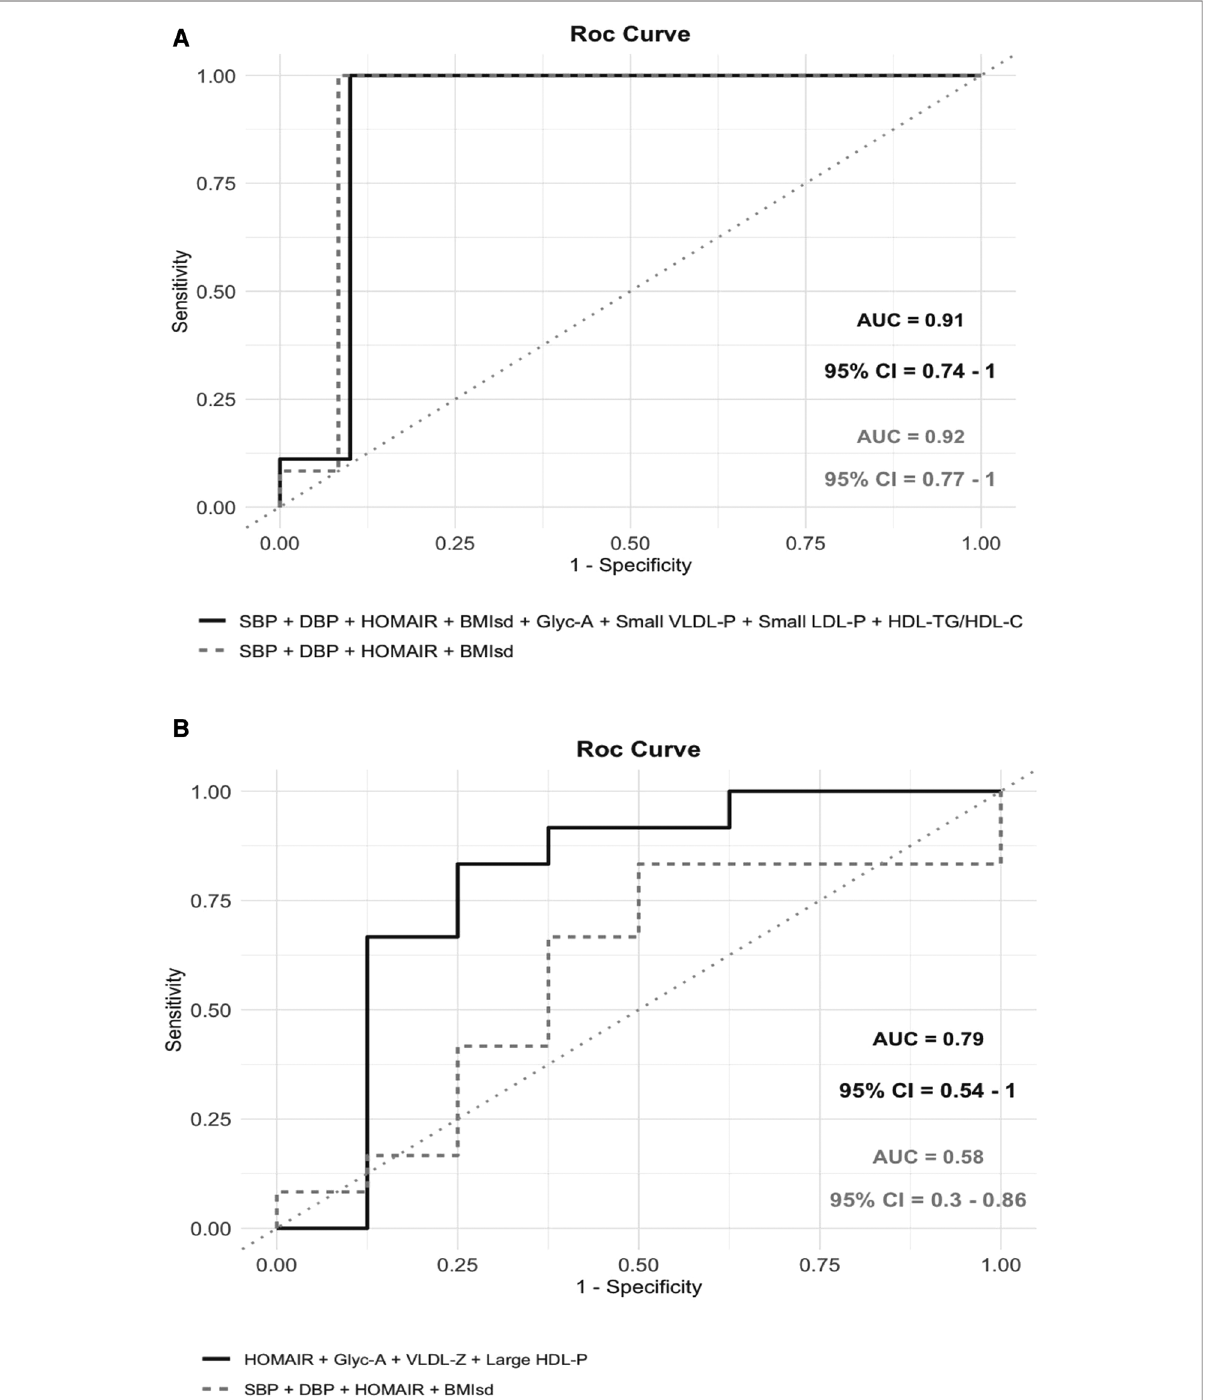
FIGURE 4 Comparative analysis between ROC curves considering only traditional cardiovascular risk factors (body mass index standard deviation, blood pressure and HOMA-IR) and ROC curves shown in Figures 2 , 3 . ( A ) When Normal heart subjects were compared to those with severe cardiac changes, the addition of lipoprotein subclasses and glycoprotein A to the model with traditional risk factors did not change the area under the curve (AUC) (0.92 vs. 0.91) [Only traditional risk factors: AUC 0.92 (95% CI: 0.77 – 1); predictive accuracy=0.88; p -value=0.0001; out-of-bag error=0.1]. ( B ) When mild cardiac change subjects were compared to those with severe cardiac changes, the addition of lipoprotein subclasses and glycoprotein A caused an increase in the AUC (0.58 vs. 0.79) [only traditional risk factors: AUC 0.58 (95% CI: 0.3 – 0.86); predictive accuracy= 0.6; p -value=0.596; out-of-bag